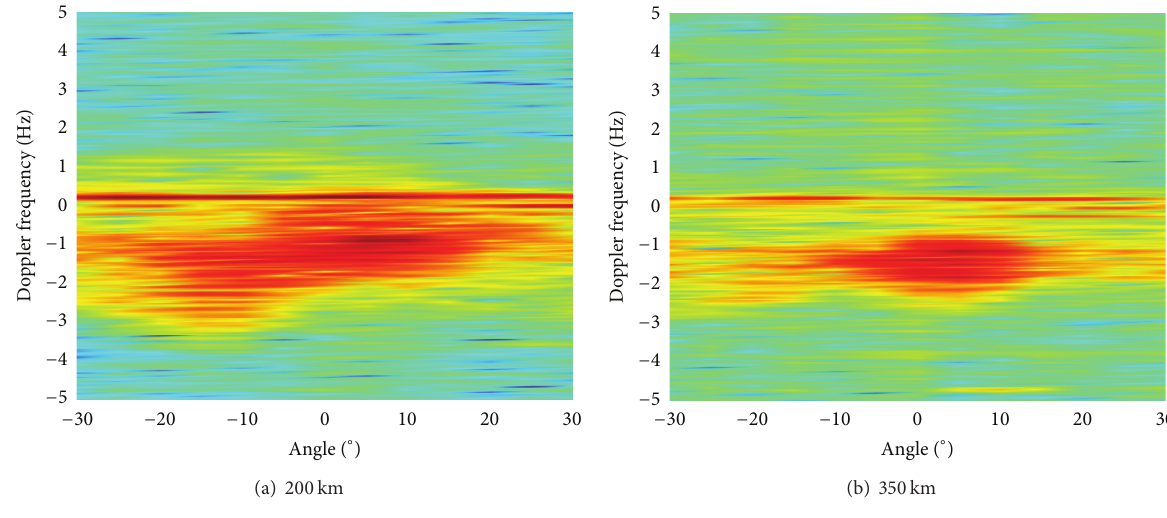
Figure 2: Angle-Doppler